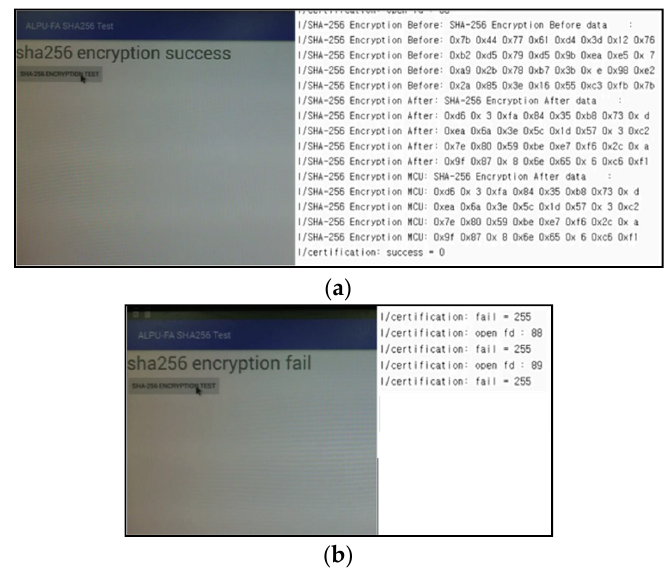
Figure 7. Demonstration of the Android application layer policies: ( a ) ALPU with the same key value; ( b ) ALPU with different key value.